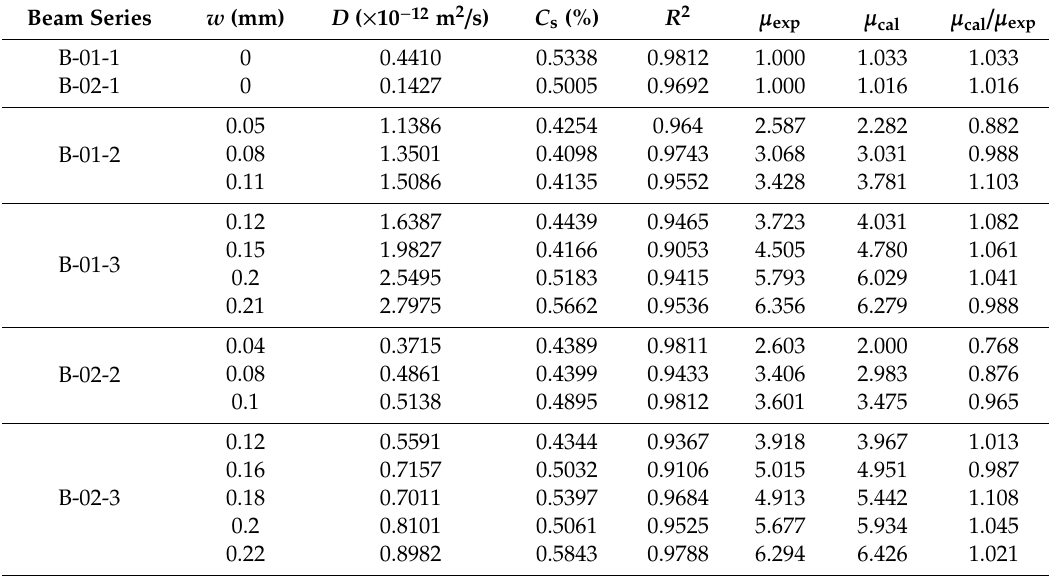
Table 4. Fitting results of chloride di ff usion coe ffi